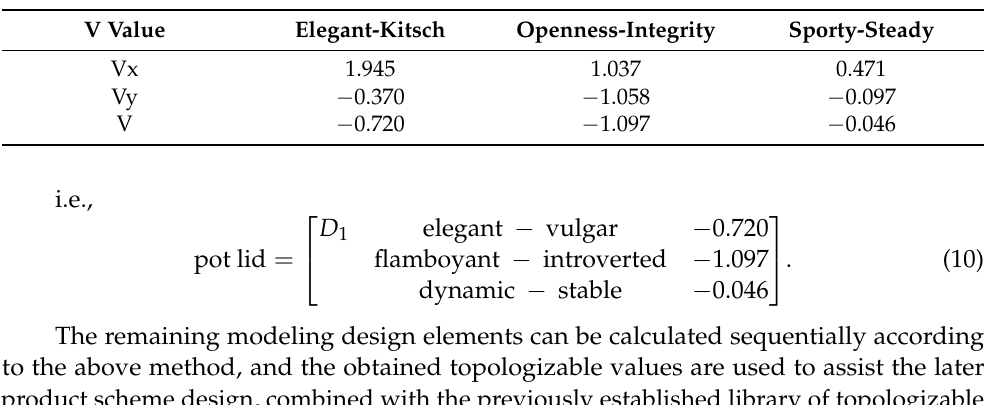
Table 10. Topologizable values of D1 categories under different imagery style